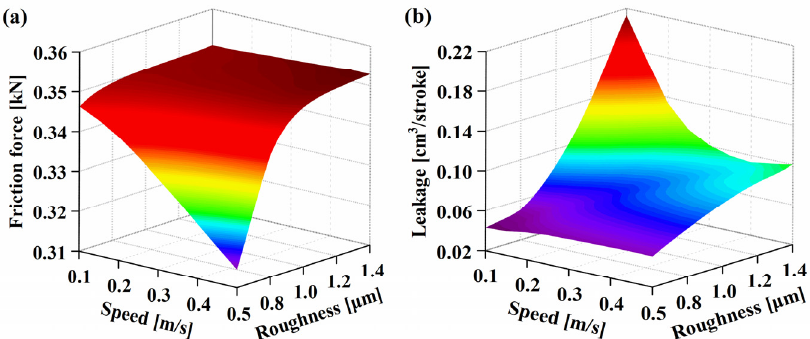
Figure 11. Variation of friction force and fluid leakage with piston speed and surface roughness: ( a ) friction force, ( b ) fluid leakage.